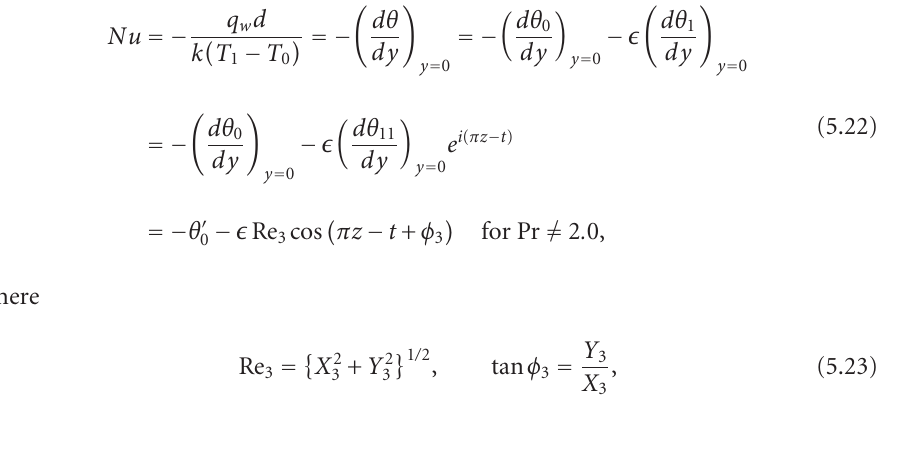
The temperature profile has been plotted against y for di ff erent values of frequency parameter ω and Reynolds number Re for Pr = 0 . 72, Ec = 10 . 0, S = 1 . 0, z = 0 . 5, t = 0 .